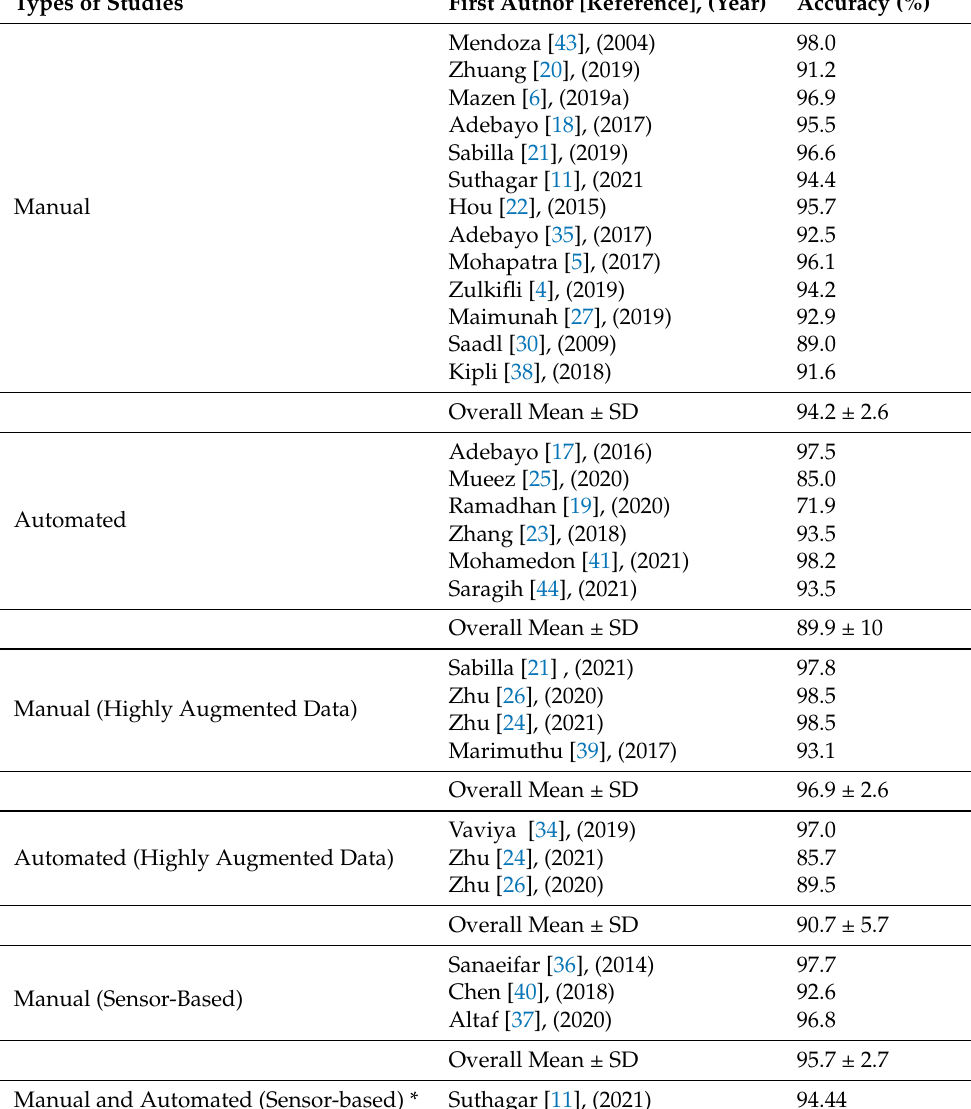
Table 2. Automated and manual feature-based classification accuracy for banana ripeness detection (* represented the study provided the overall manual and automated method accuracy).